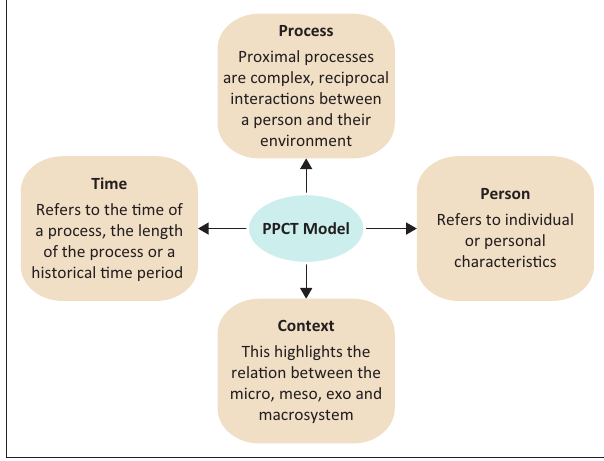
FIGURE 1: Outline of Bronfenbrenner’s process-person-context-time